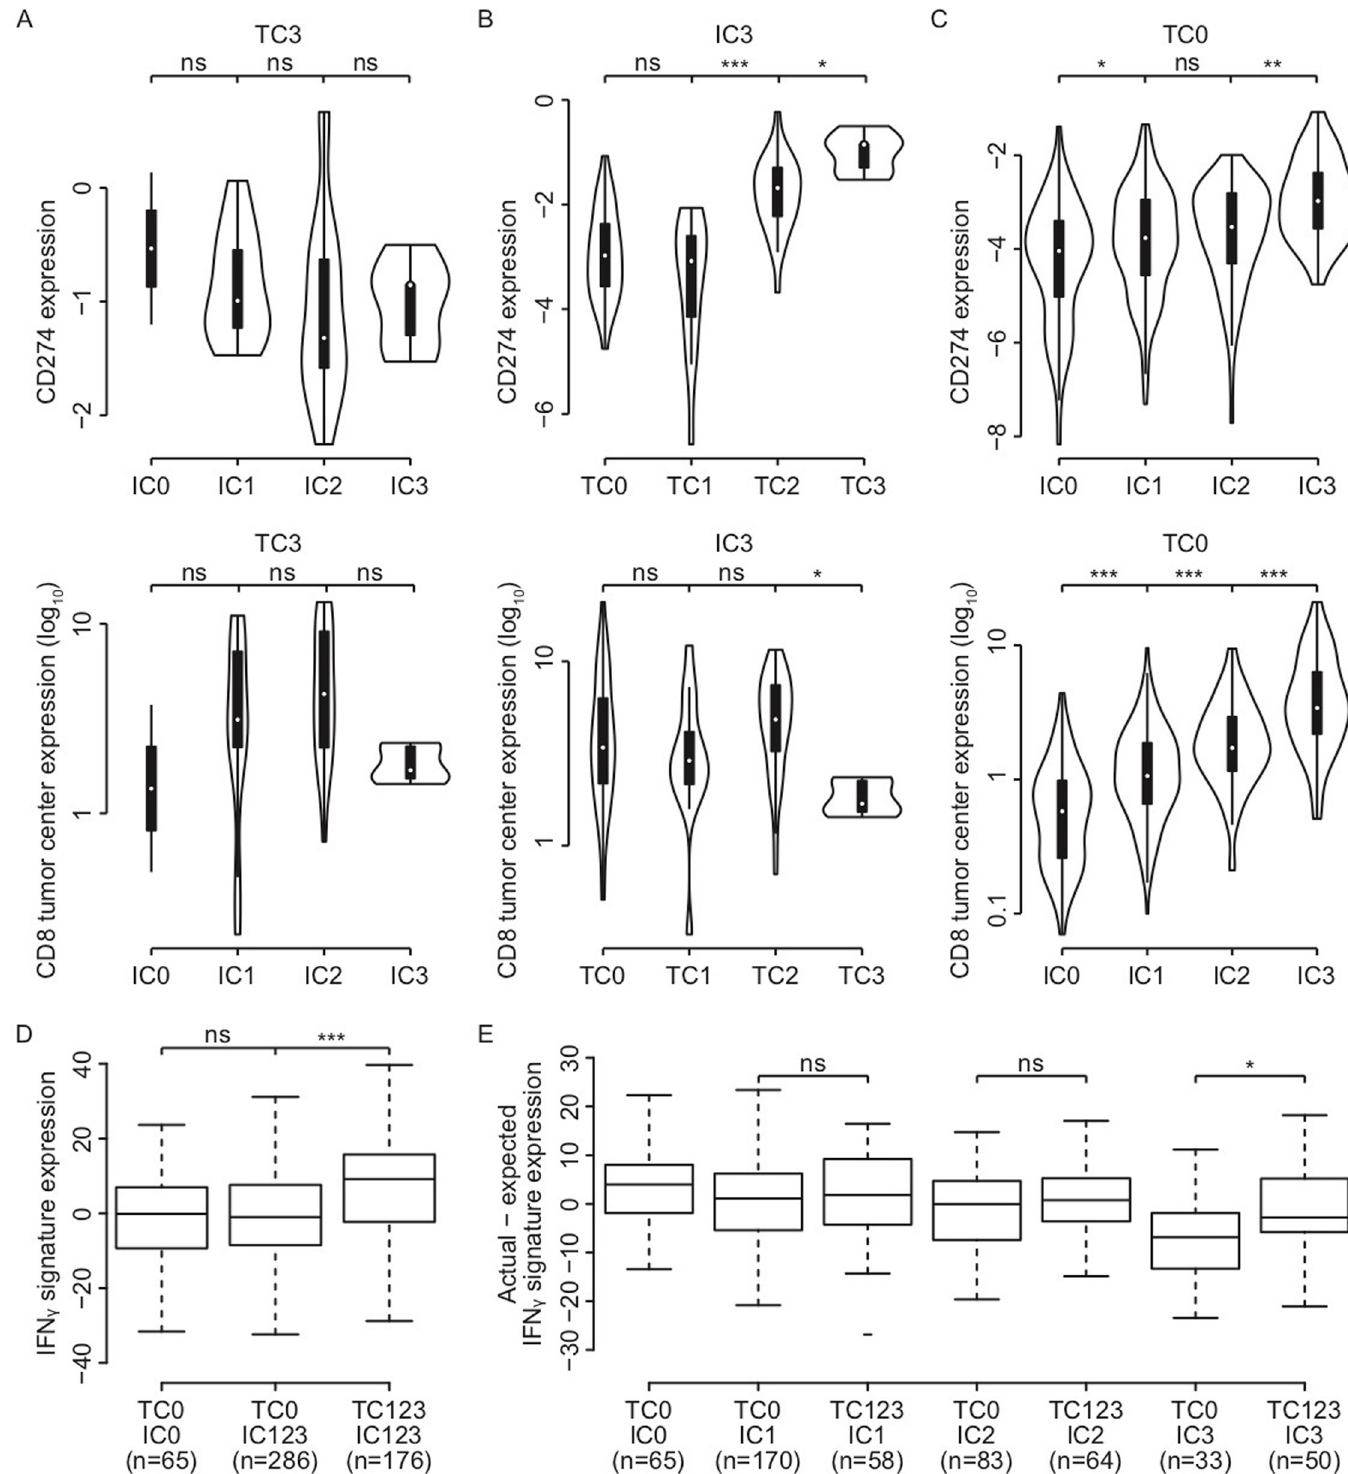
Fig 2. Associations of mRNA expression of CD274 , infiltration of CD8 and the IFN γ response signature in non-overlapping PD-L1 expressing subgroups. (A) Relative mRNA expression of CD274 and CD8 infiltration in TC3 tumors based on various levels of IC (n = 39). (B) Relative mRNA expression of CD274 and CD8 infiltration in IC3 tumors based on various levels of TC (n = 83). (C) Relative mRNA expression of CD274 and CD8 infiltration in TC0 tumors based on various levels of IC (n = 351). (D) Relative mRNA expression of the IFN γ response signature in non-overlapping PD-L1 subgroups: TC0&IC0, TC0/IC123 and TC123/IC123 (n = 530). (E)